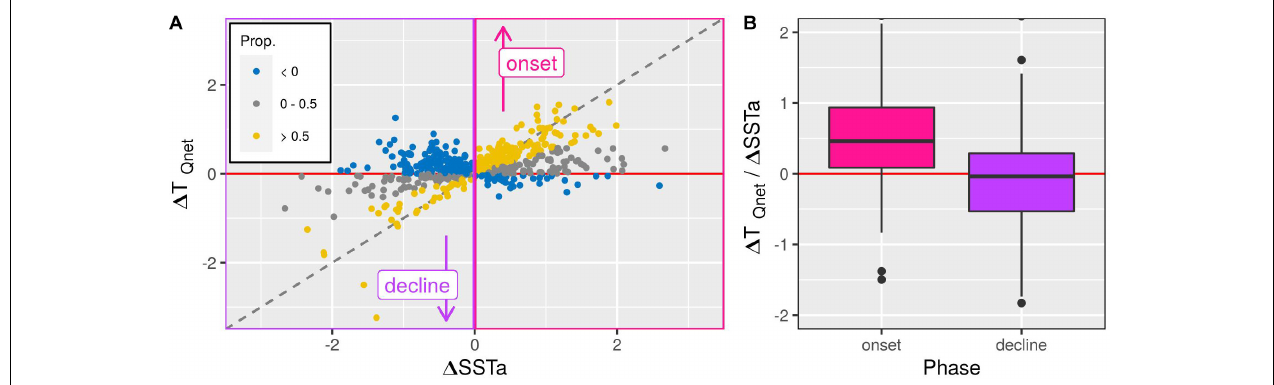
FIGURE 2 | Plots showing the ranges in the contributions of T Qnet to SSTa during the onset and decline of marine heatwaves (MHWs). (A) Scatterplot showing how the magnitudes of change in SSTa during the onset ( (cid:49) SSTa > 0, pink box) and decline ( (cid:49) SSTa < 0, purple box) of MHWs matched to T Qnet . The yellow points show when more than half (0.5) of the proportion of the change in SSTa can be attributed to T Qnet . Gray points show a positive but not majority input from T Qnet (0 – 0.5). Blue points show when T Qnet contributed heat to SSTa contrary to the tendency of the anomaly (i.e., negative heat flux during the onset of a MHW, and positive during the decline). Points falling on the gray dashed line show a one-to-one relationship between SSTa and T Qnet , while points on the red line show no relationship. (B) Boxplots showing the proportions of change between SSTa and T Qnet during the onset and decline of all MHWs. The middle black line shows the median proportion of change, and the tops and bottoms of the boxes show the interquartile range (25th–75th percentiles). The whiskers show all MHWs that fall within 1.5 times the interquartile range. Any outliers (black dots) outside of ± 2 have been excluded from the plot. The horizontal red line denotes 0, where no contribution to SSTa is being made by T Qnet . Note that any values below 0 for both onset and decline show that T Qnet was hindering the onset or decline of the MHW.